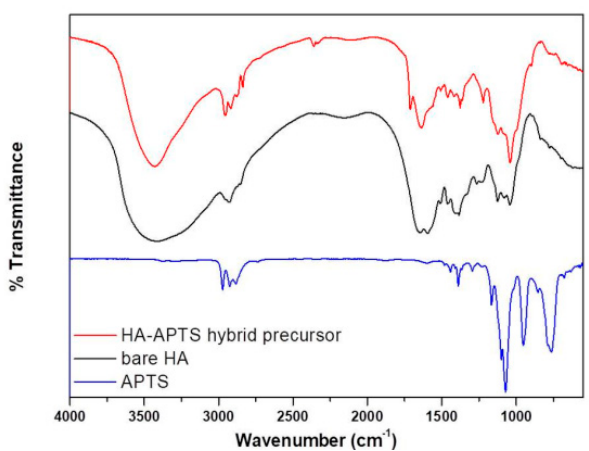
Figure 6. FT-IR spectra of APTS, bare HA and the HA-APTS hybrid precursor.